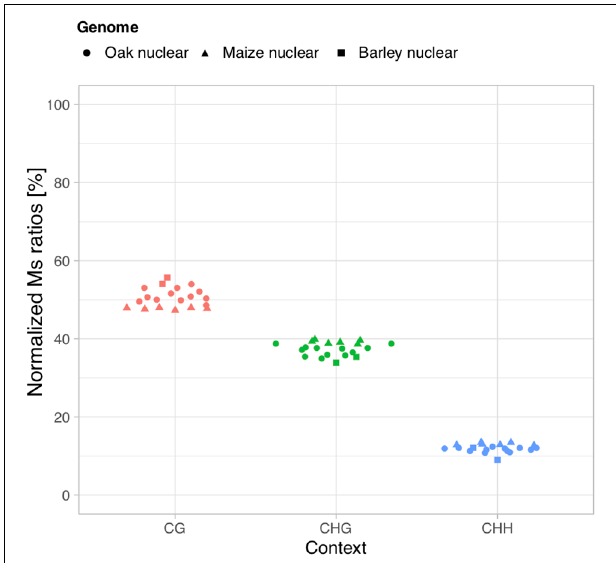
FIGURE 3 | Relative contributions of CG, CHG, and CHH contexts to DNA methylation. Normalized Ms ratios are shown for nuclear DNA analyzed from sequencing data generated based upon USER-treated extracts of 12 ancient oak, 6 maize, and 2 barley samples.